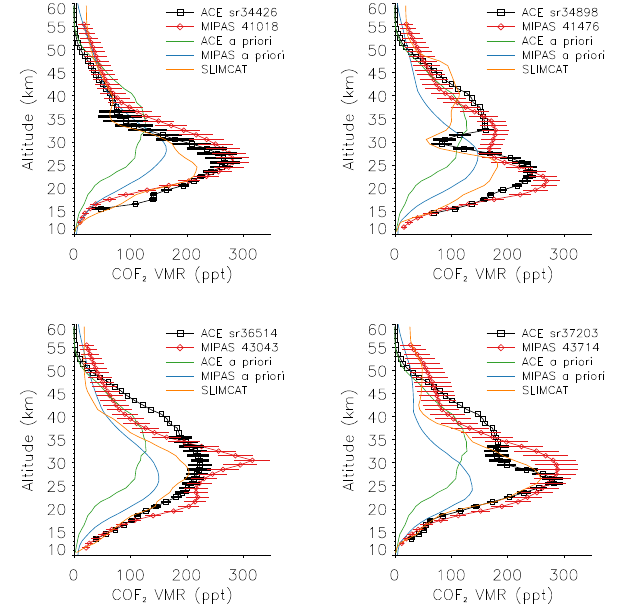
Figure 7. ACE-FTS and MIPAS near-coincident individual profiles taken from the period September 2009 to August 2010. The loca- tions and times of the eight observations can be found in Table 6. The error bars represent the retrieval random errors. The plots also contain the a priori profiles and calculated SLIMCAT profiles for the location and time of each ACE-FTS observation.